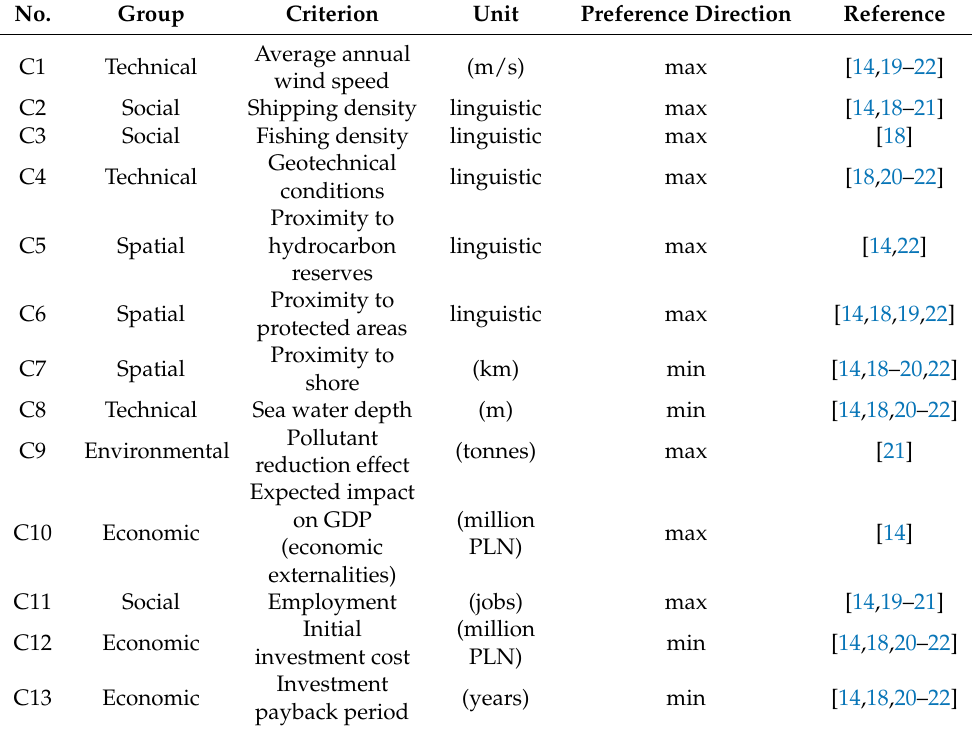
Table 1. Criteria for assessing offshore wind farms projects.